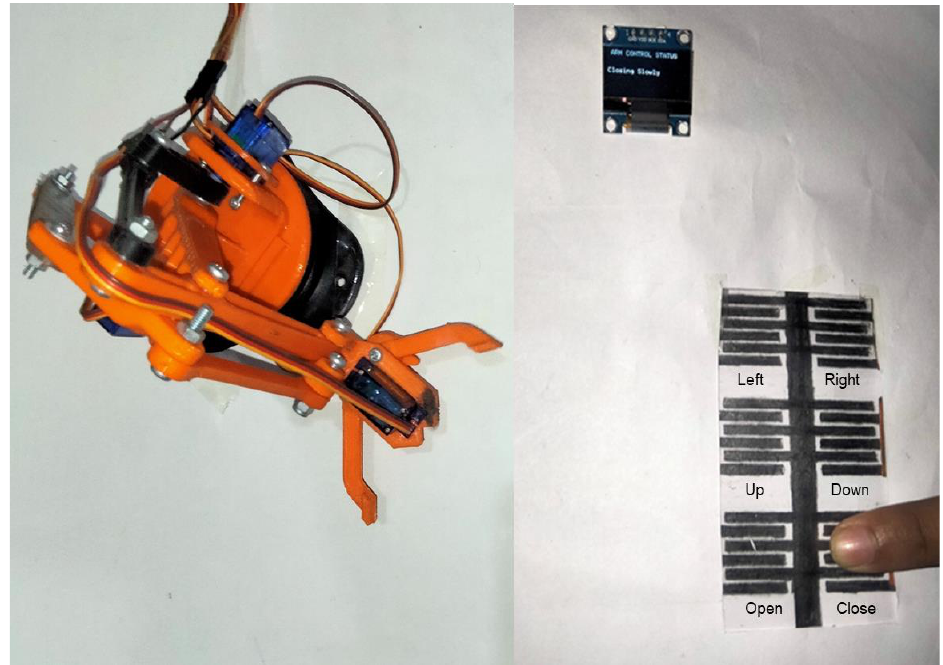
Figure 5. Picture of the CPS, keypad-based HMI integrated with a robotic arm. An OLED was connected to the system to show the status of the sensors under no touch, low-force touch, or high-force touch. In addition, a message regarding low- and high-force touch was displayed using an OLED, to guide the user. The user would be informed about the sensor on which a touch was detected and whether the respective motor is moving fast or slow in response to the touch. Figure 6 displays all possible messages on the OLED. These pictures were taken during the keypad testing to show the status of the motors, either moving the arm slowly or rapidly. The top row of Figure 6 displays the status of the motor controlling the left/right movement of the robotic arm. In response to the input provided by the user, the motor can move the arm left or right at a slow or fast speed. All possible statuses of this motor are shown in the top row. The middle row displays the status of the up/down motor that can move in an upward or downward direction at a slow or fast speed. The bottom row represents the status of the jaw, which can open or close at a slow or fast speed, in accordance with the input provided by the user, where a slow movement is due to a low-force touch and fast movement is due to a high-force touch. The presented results show that the CPS touch keypad fabricated from green and facile materials and fabrication techniques are capable enough to control the machines intelligently based on the touch pressure. The obtained results are sensitive to the paper type and the surface roughness of the paper can affect the results. Further, the reported fabrication process is manual and cannot be used for large areas and speedy manufacturing. Future studies can focus on a speedy fabrication process compatible with graphite-based green electronics to achieve high-throughput, large-area fabrication.